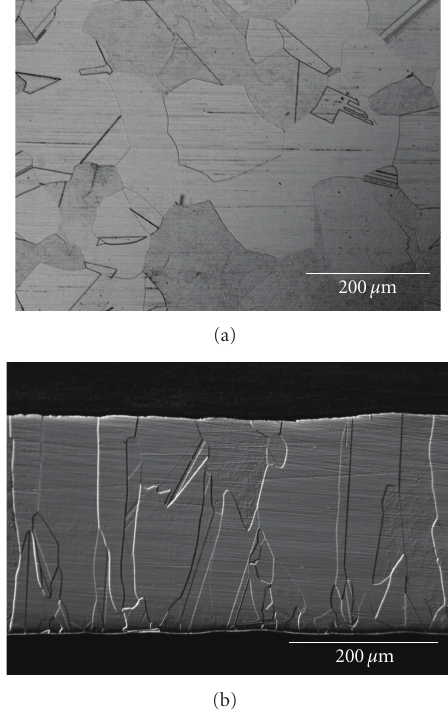
Figure 6: Optical microscope images for (a) surface and (b) cross section of as-grown ribbon-type silicon wafers at a substrate temperature of 1000 ◦ C, time interval of 2.5sec, moving velocity of substrates of 485 cm/min, and blowing rate of Ar gas of 0.8 Nm 3